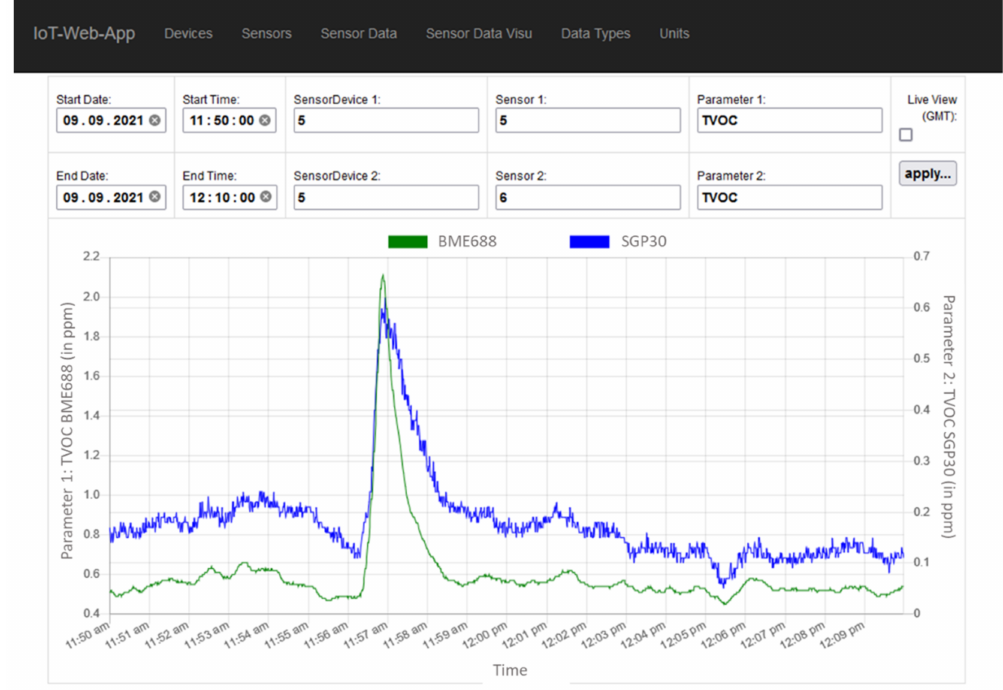
Figure 5. Visualizing tool of the IoT-Web-App showing the responses of the BME688 and the SGP30 to a small VOC